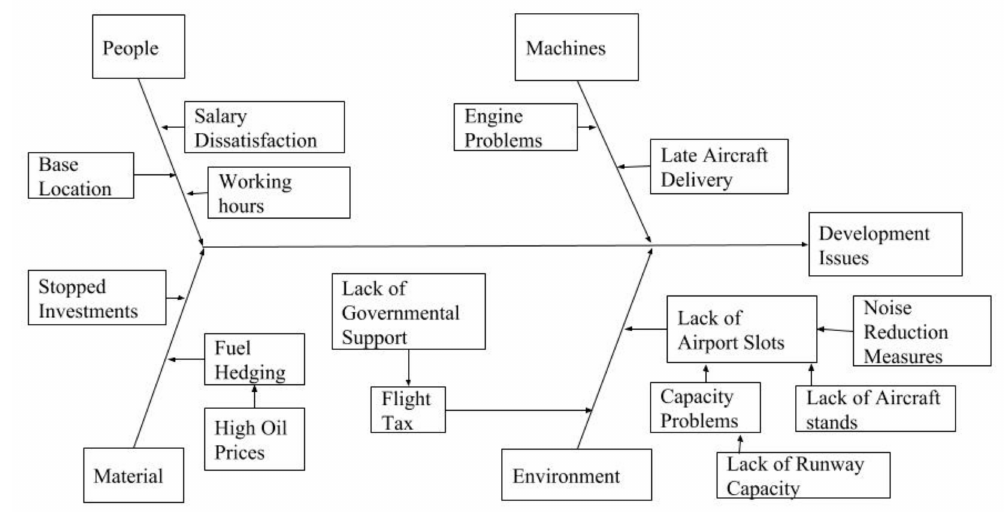
Figure 1. Ishikawa diagram of the airline development issues. Source: compiled by authors based on issues described in the